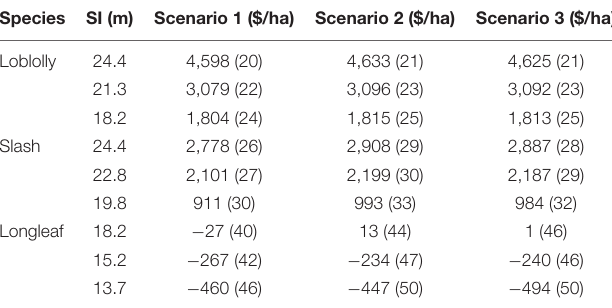
TABLE 5 | Land expectation values for loblolly, slash, and longleaf pines across site indices without income from pine straw raking.